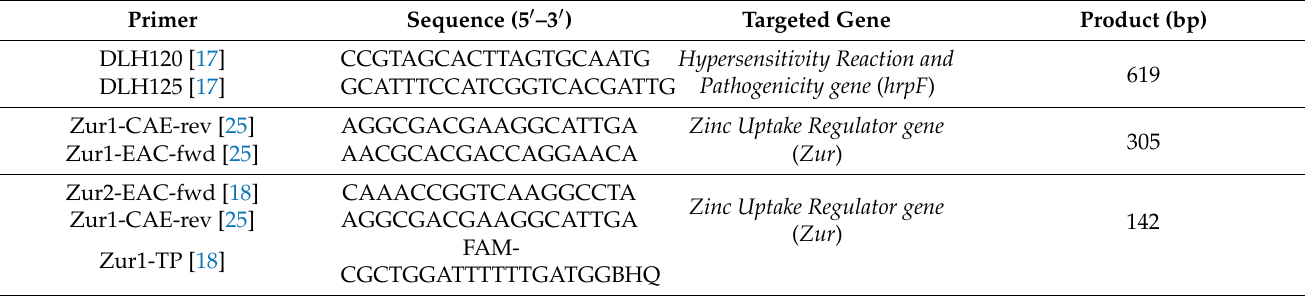
Table 1. List of used primers with their sequences, targeted genes and product